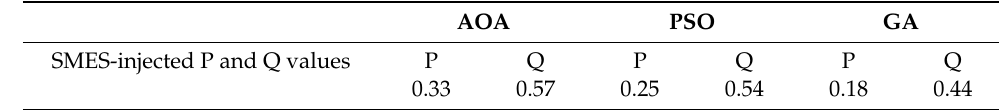
Table 7. SMES-injected active and reactive power for L-L-G scenario. AOA